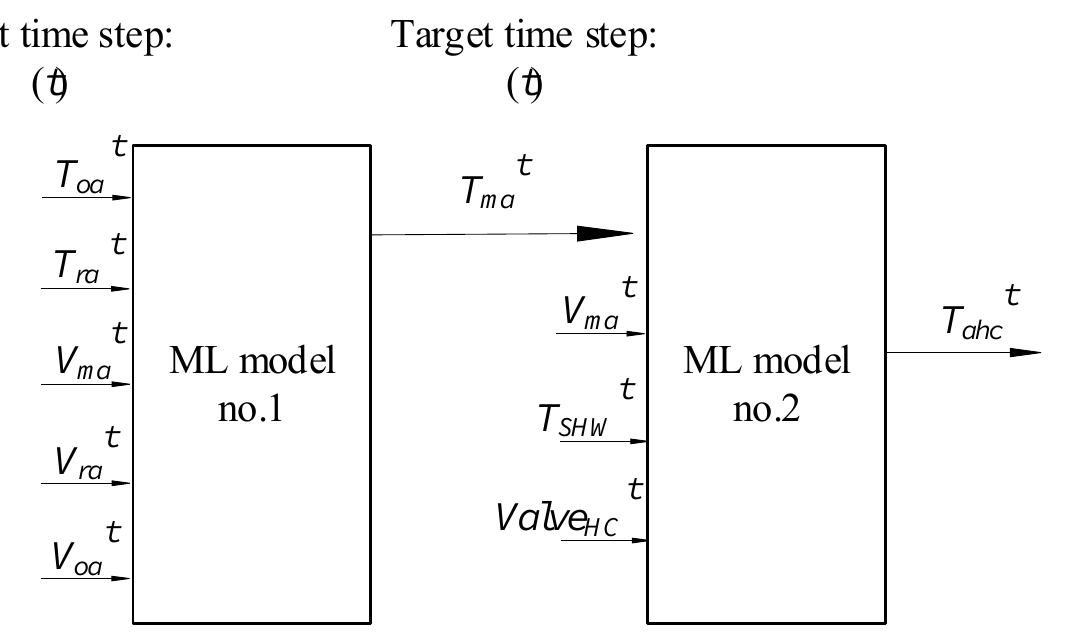
Figure 4. Schematic SVR model for prediction of target variables T ma and T ahc at time t for fault symptom detection.